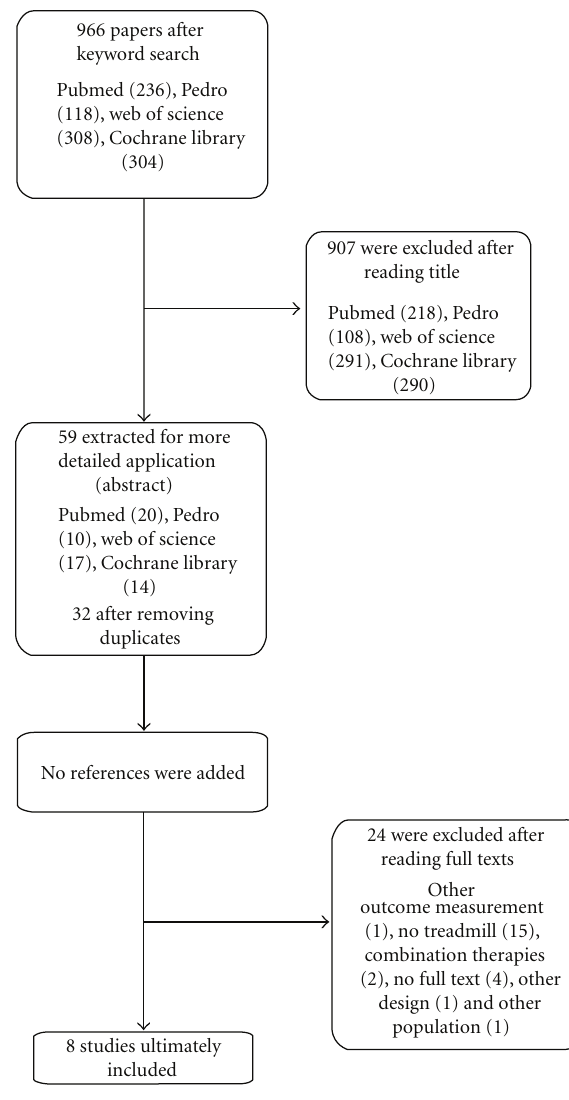
Figure 1: Flowchart of the search